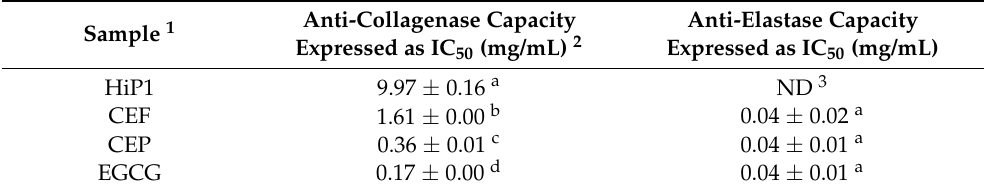
Table 5. Anti-collagenase and anti-elastase potential of S. filipendula extracts. Sample